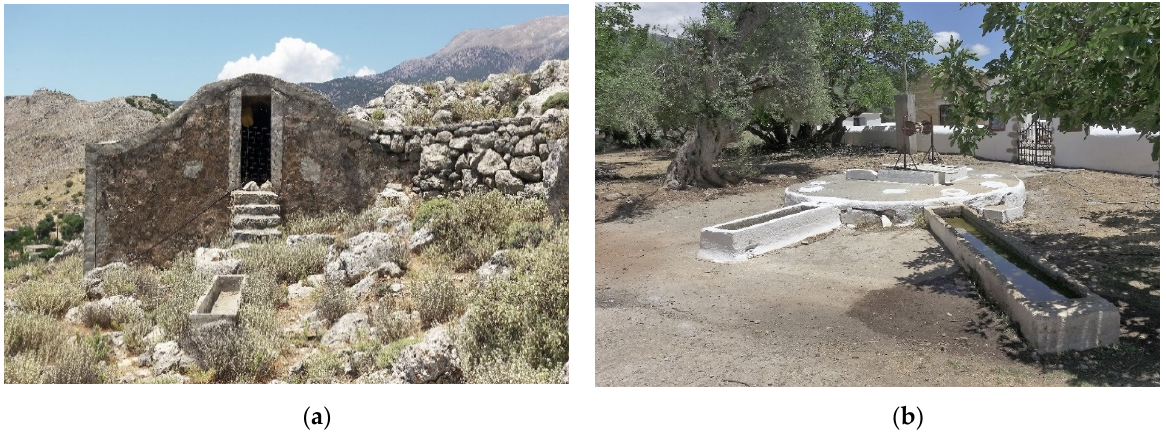
Figure 12. Anopolis: ( a ) A Venetian cistern and ( b ) a well in plateau in the neighborhood Gyros (photos by A. N. Angelakis).